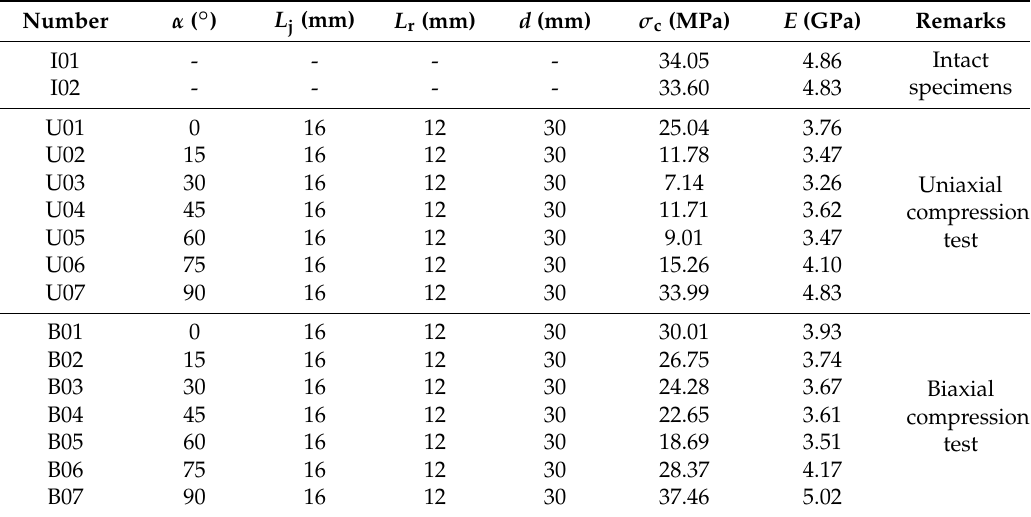
Figure 1. Schematic view of a joined rock sample. ( a ) uniaxial compression; ( b ) biaxial compression. Table 1. Mechanical parameters of